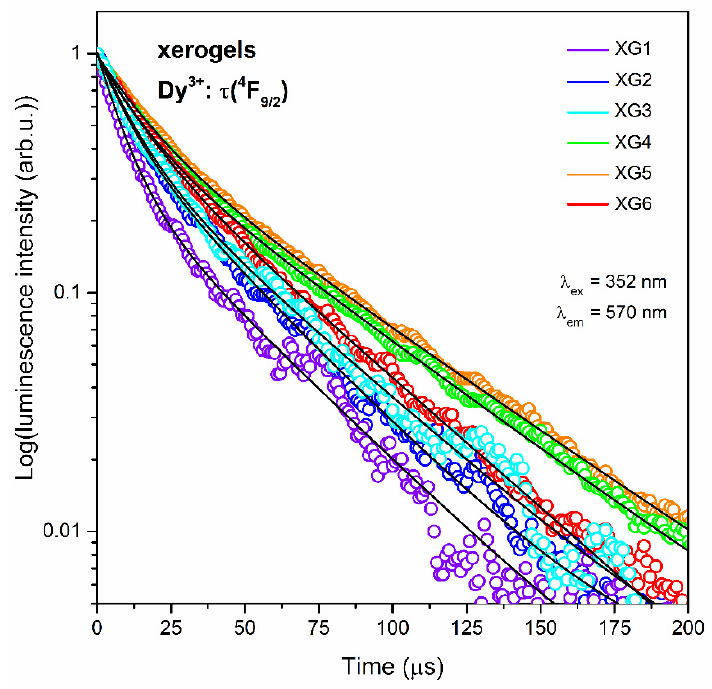
Figure 6. Luminescence decay curves recorded for the 4 F 9/2 state of Dy 3+ ions in amorphous silicate xerogels ( λ ex = 352 nm, λ em = 570 nm). Table 4. Decay components ( τ n ), residual weighting factors (A n ), and average decay times ( τ avg ) of the 4 F 9/2 state of Dy 3+ in fabricated silicate